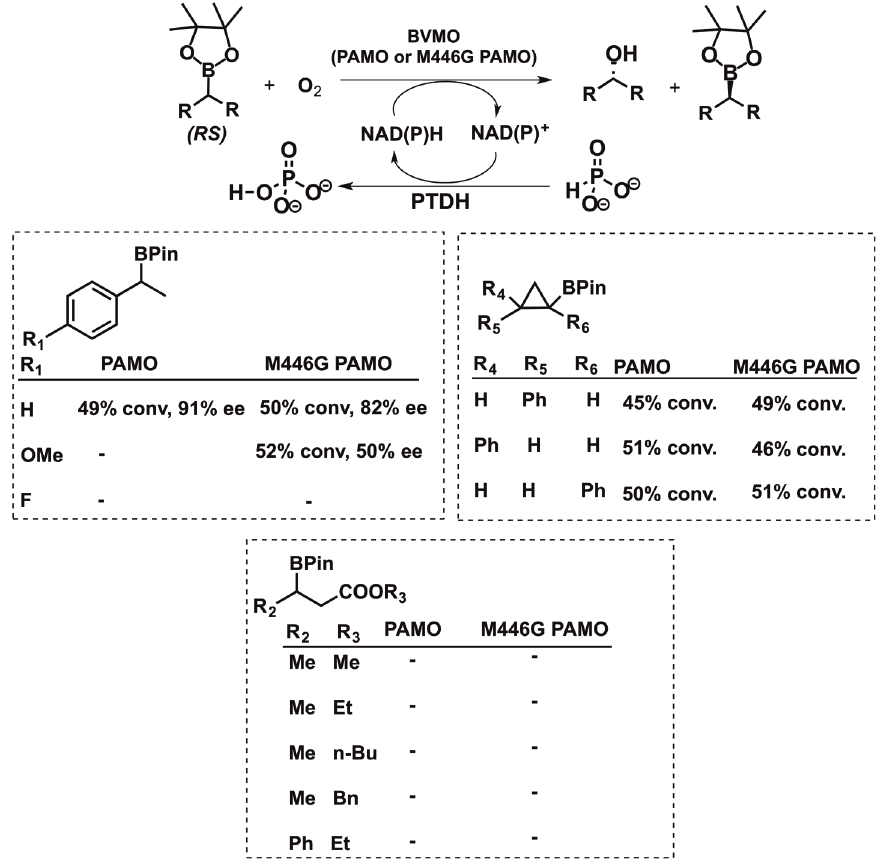
Figure 51 - Reactions of several organoboron compounds with BVMOs.